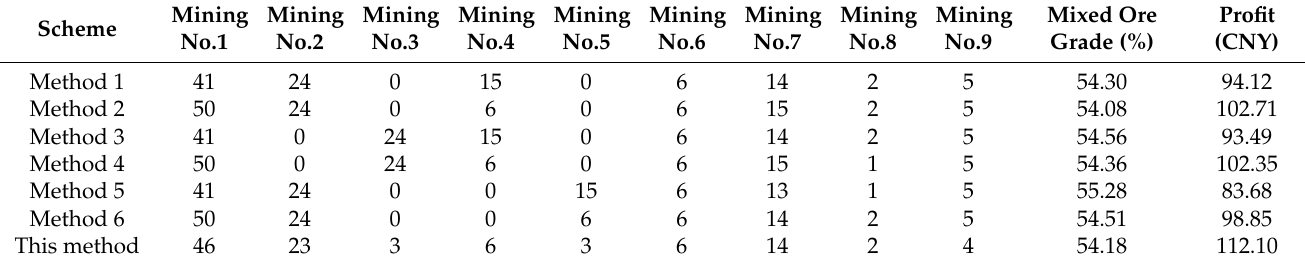
Table 10. Ore blending scheme in